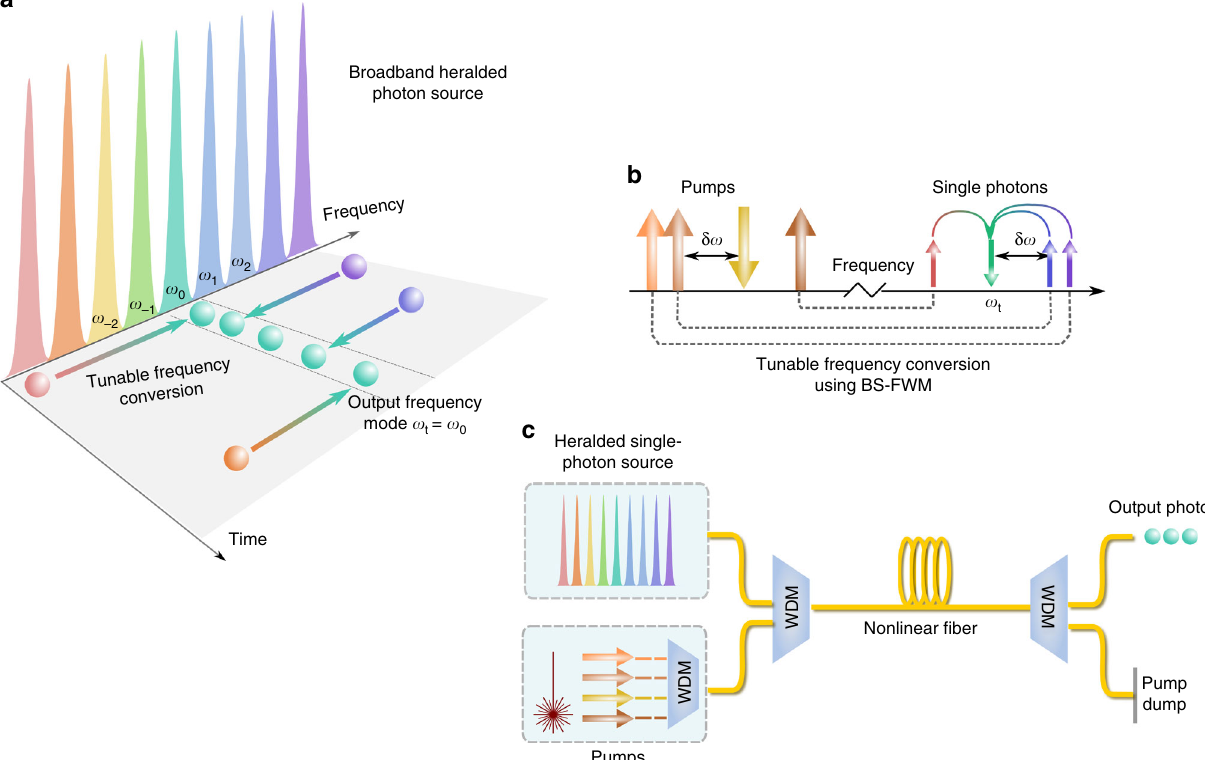
Fig. 1 Principle of a frequency multiplexed single-photon source. a Multiple narrowband frequency channels { ω 0 , ω 1 ...} are extracted from a broadband single-photon source. Tunable frequency conversion is used to convert photons from different channels to a common target frequency mode ω t . b Tunable frequency conversion using Bragg scattering four-wave mixing (BS-FWM): two strong classical pumps drive the interaction between the input and target ( ω t ) single-photon fi elds. The frequency separation δω between the pump fi elds determines the frequency shift of the single photons, and additional pump fi elds can be used to increase the number of possible values of δω . c Fixed-loss operation of frequency multiplexing: single photons and BS-FWM pumps are combined using wavelength division multiplexers (WDM), and all active frequency switching takes place in a single nonlinear fi ber/waveguide. Additional channels can be added by introducing additional pumps, without introducing losses in the path of the single